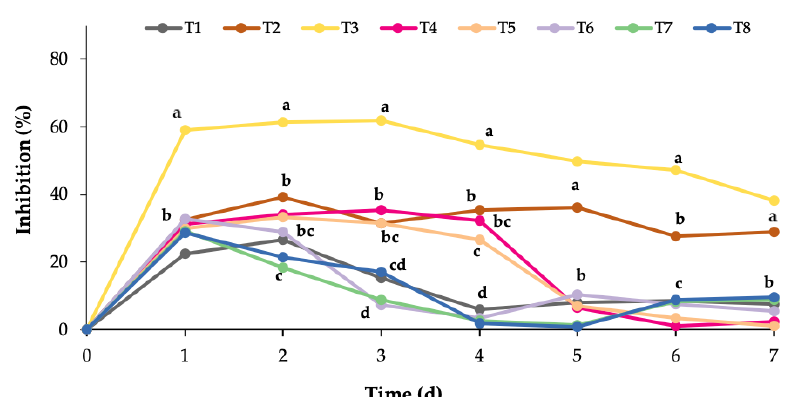
Figure 5. Inhibition (%) of the fungus Colletotrichum gloeosporioides by the TEP6 bacteria incorporated into freshly processed films (storage day 0) and evaluated for 7 days. The letters represent the analysis of variance to observe the differences between each formulation per